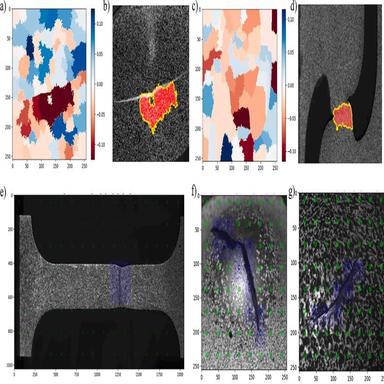
Heatmap images of explanation segments (a), (c) and the top segment (or superpixel) (b), (d) used by the model to generate its predictions for the punch and shear testing experiments. In (e) and (f-g), the crack location is inferred for UT and different punch test images by predicting the status of each patch of the original image.